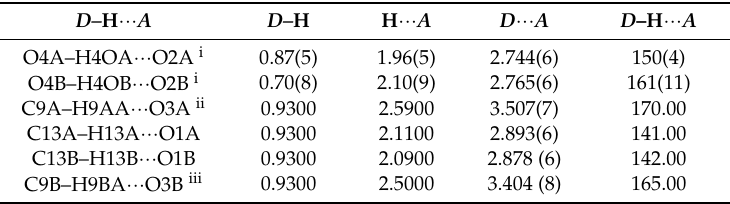
Table 3. Hydrogen-bond geometry (Å, ◦ ) of 1 .